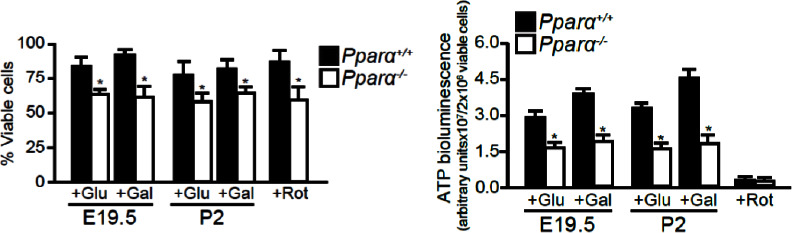
DOI:
http://dx.doi.org/10.7554/eLife.11853.020